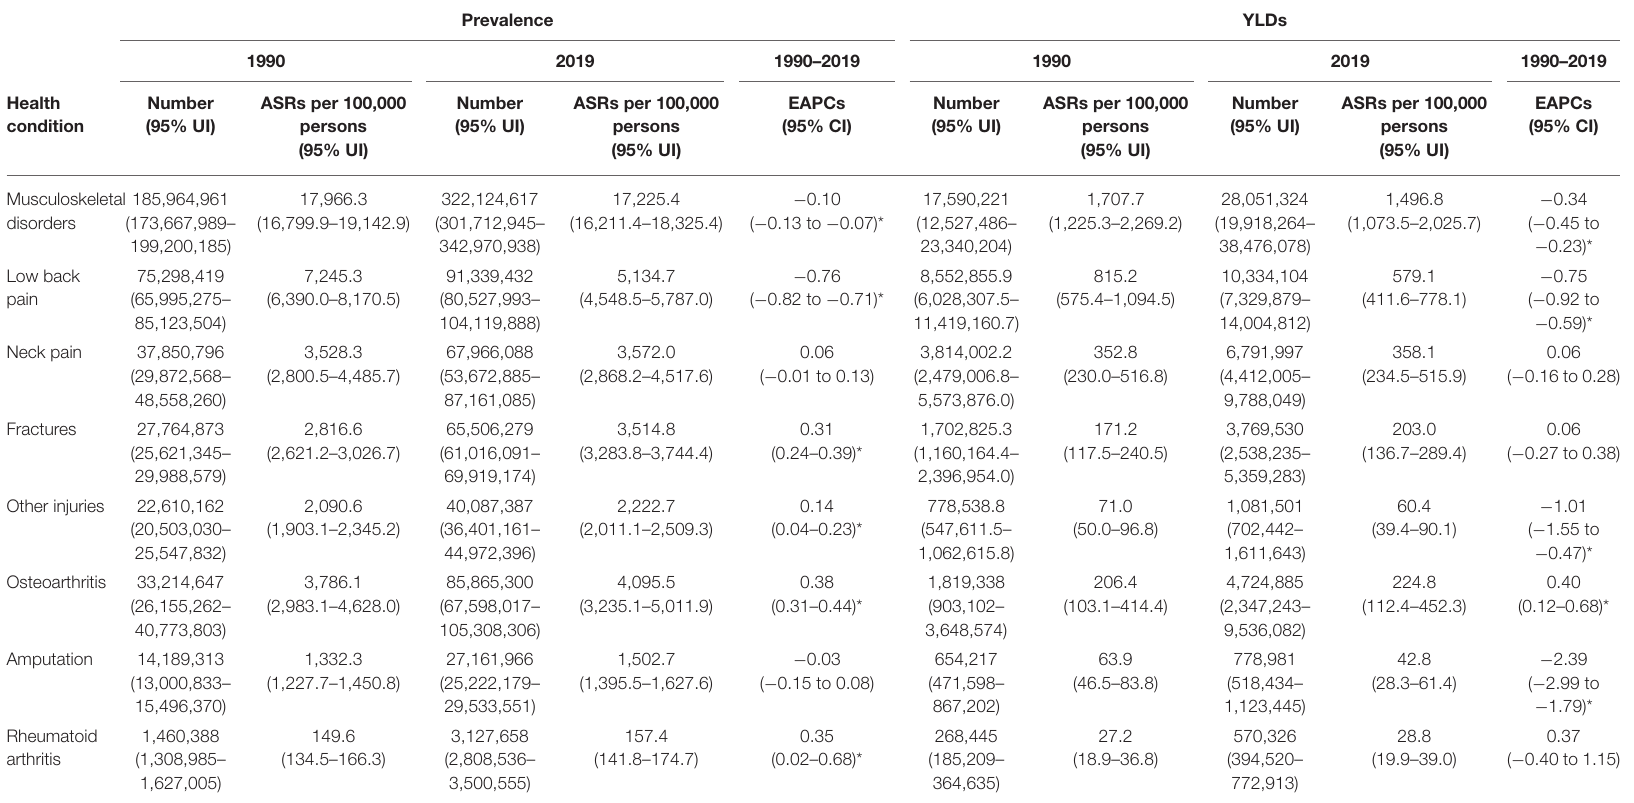
TABLE 1 | Musculoskeletal rehabilitation needs and trends in China from 1990 to